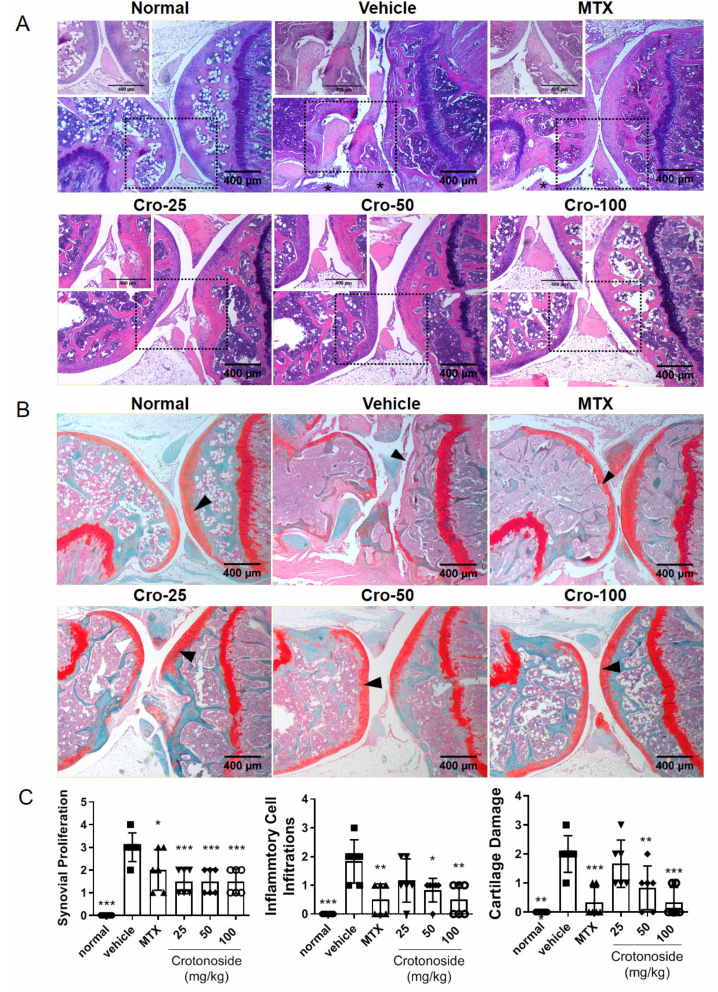
Figure 2. Histopathological damages associated with collagen-induced arthritis were mitigated by crotonoside. Hind knee joint tissue sections stained with ( A ) hematoxylin and eosin (H&E, magnification of background image, × 100; insert, × 200) or ( B ) Safranin O staining representation of di ff erent mouse groups. ( C ) Histopathological indications, synovial proliferation, cell infiltration, and cartilage damage were quantified based on 200 × magnification images. Representative data are shown from one of three independent experiments and values are expressed as mean ± SD ( n = 6 mice per group). Asterisks and arrowheads indicate the synovial hyperplasia and proteoglycans, respectively. * p < 0.05, ** p < 0.01, *** p < 0.001, versus CIA vehicle group, as determined by a one-way ANOVA with Dunnett